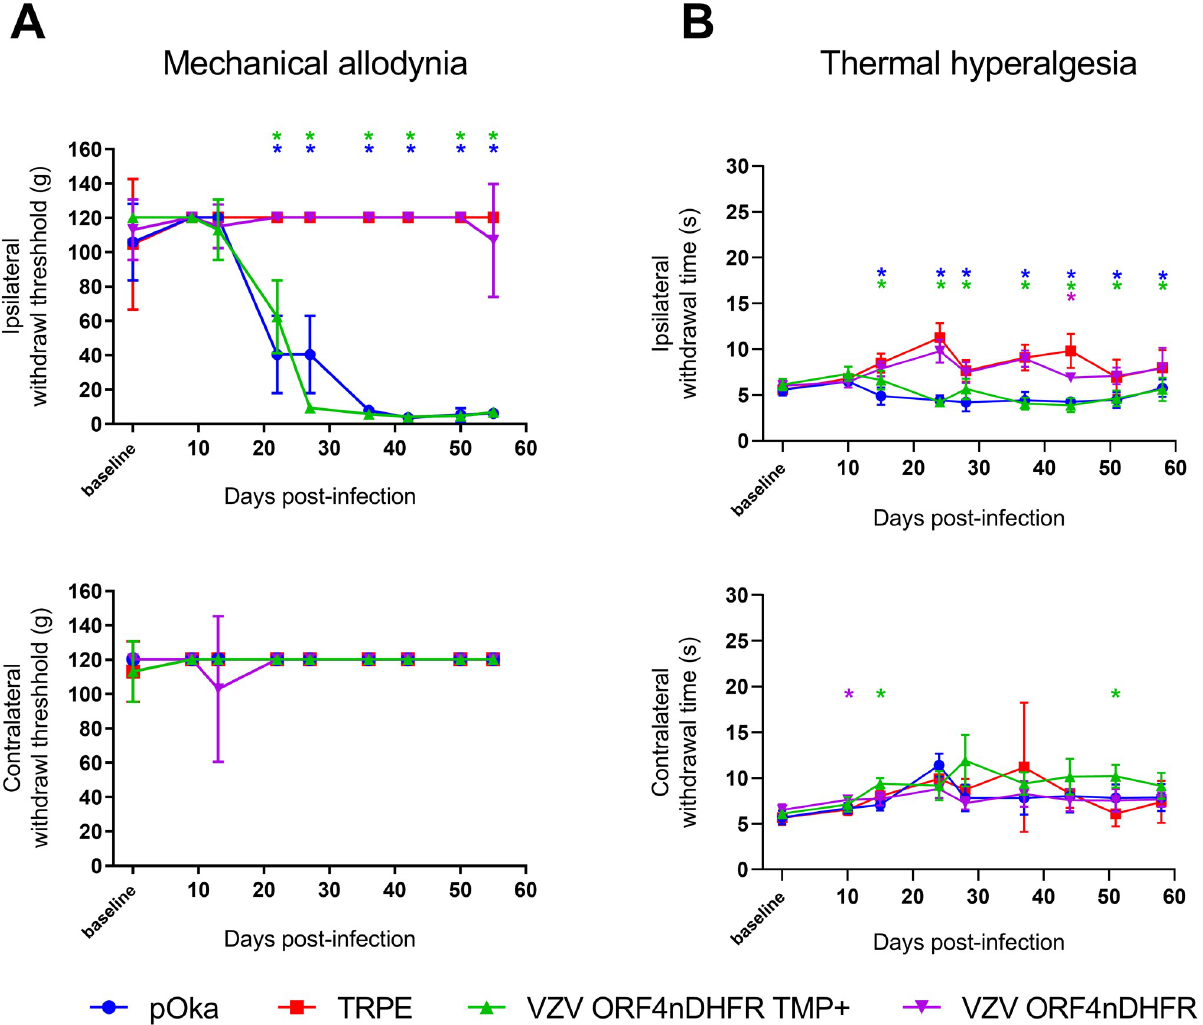
Fig 9. Footpad inoculation by VZV ORF4nDHFR induces mechanical and thermal hypersensitivity only if IE4 is stabilized under growth- permissive conditions. Male Sprague-Dawley rats (n = 6/group) were inoculated with 2x10 5 PFU pOka (blue circle), VZV ORF4nDHFR with 500 nM TMP (green triangle) or without TMP (purple triangle), or uninfected TRPE equivalents (red square). (A) MA of inoculated footpad (top) vs contralateral (bottom). (B) The same group of rats were tested for TH of the inoculated footpad (top) vs contralateral, uninoculated footpad (bottom). Error bars: SD. Statistics: Two-way ANOVA with Bonferroni multiple comparison to TRPE negative control where � p < .05 and color coded by group.